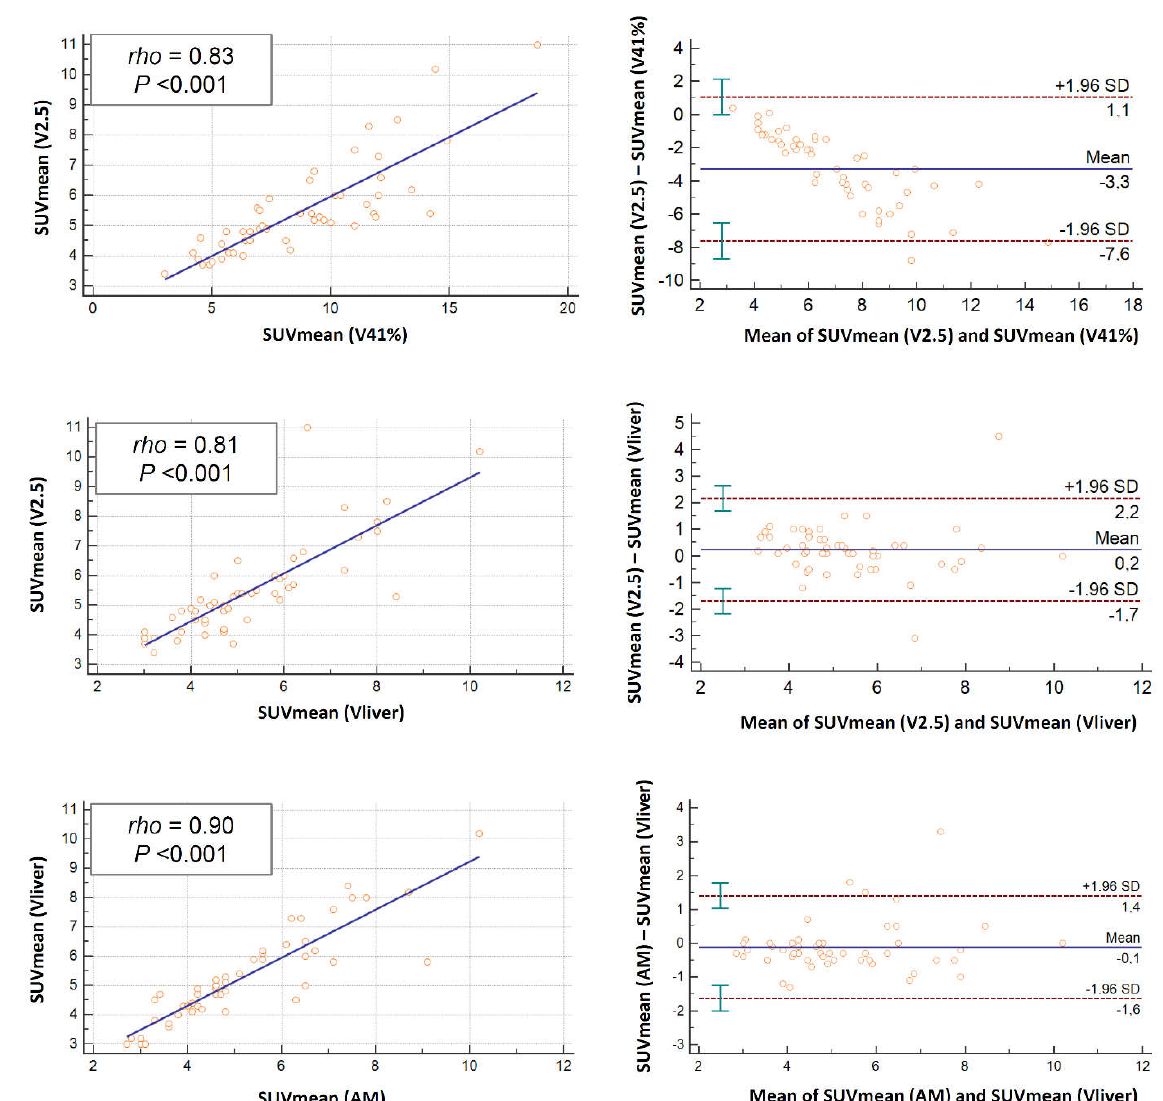
Figure 2. Scatter plots for linear regression with corresponding correlation coefficient (rho) and